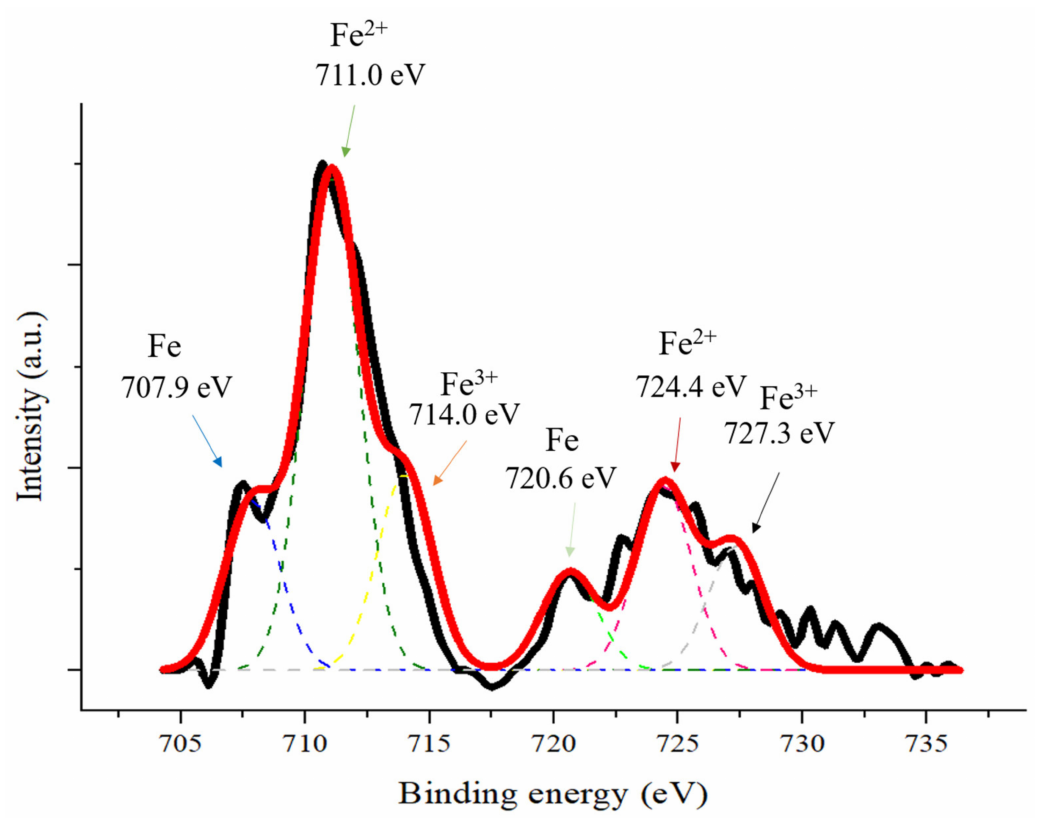
Figure 4. ESCA Fe-2p spectrum measured from CNTs grown on silicon, at 650 ◦ C, in a vapor mixture of ferrocene, camphor, water, and